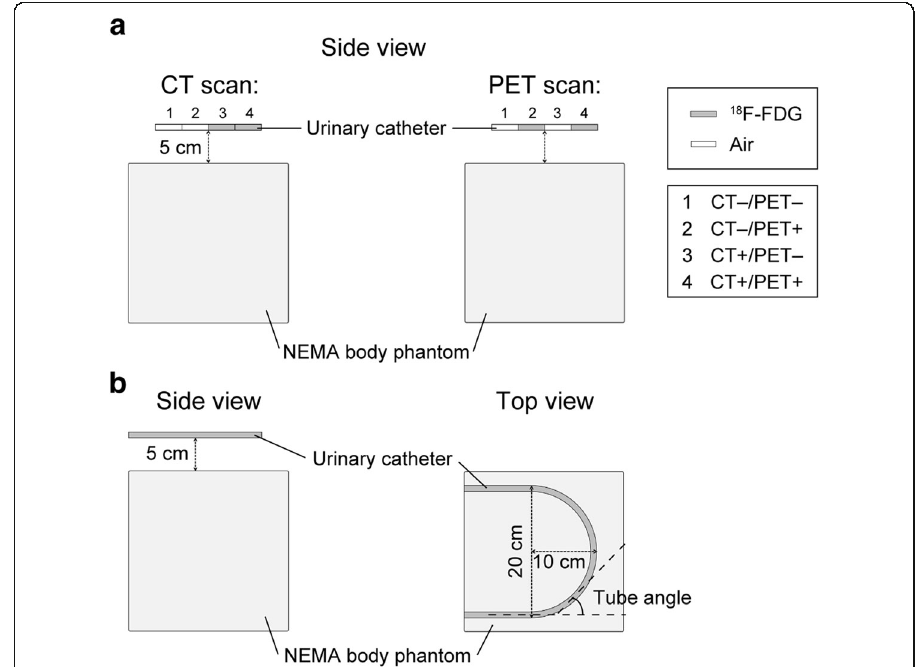
Fig. 1 The phantom studies. Urine shift pattern ( a ). Tube curve pattern ( b